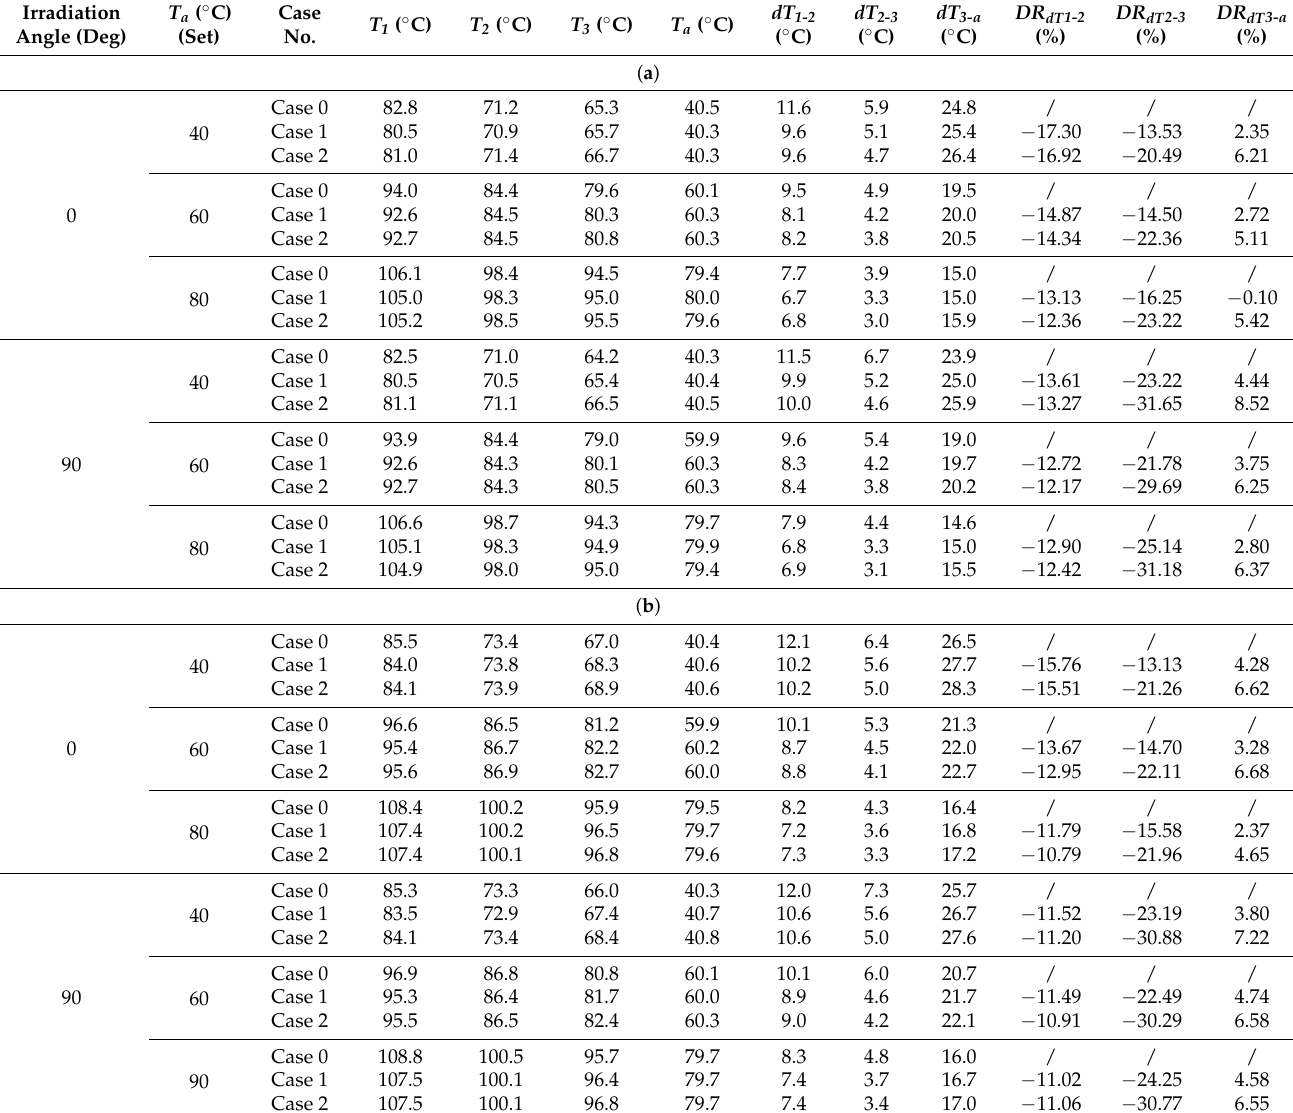
Table 2. Experimental results of temperature and temperature difference of automotive LED lamps: ( a ) high beam; ( b ) low